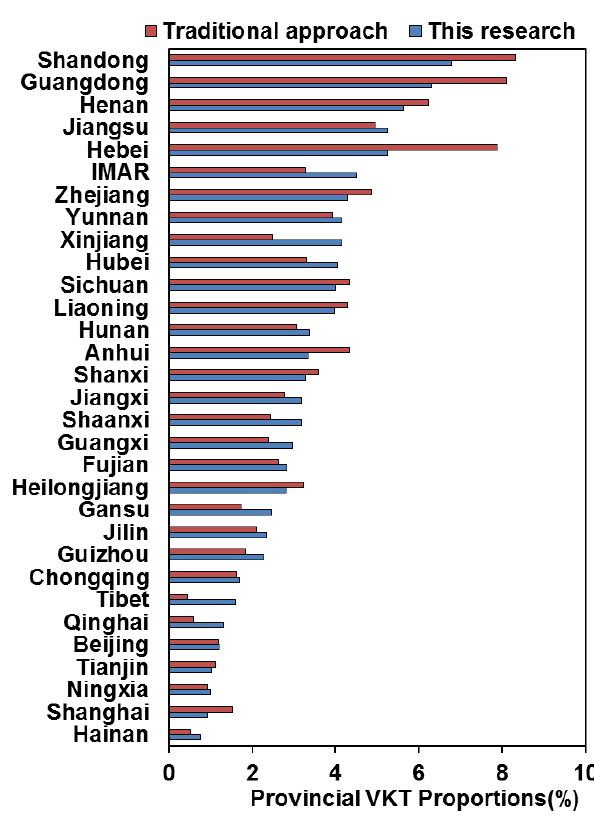
Figure 11. Provincial VKT proportions from the REIB approach and traditional